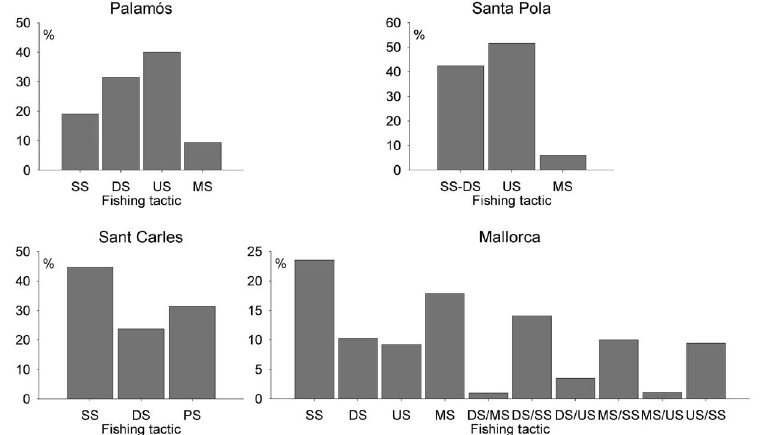
Fig . 3. – Percentage in biomass of total landings for the different fishing tactics obtained analyzing daily landing data from GSA05 (Mallorca) and three important ports of GSA06 (Palamós, Santa Pola and Sant Carles de la Ràpita). SS: shallow shelf; DS: deep shelf; PS: pelagic deep shelf; US: upper slope; MS: middle